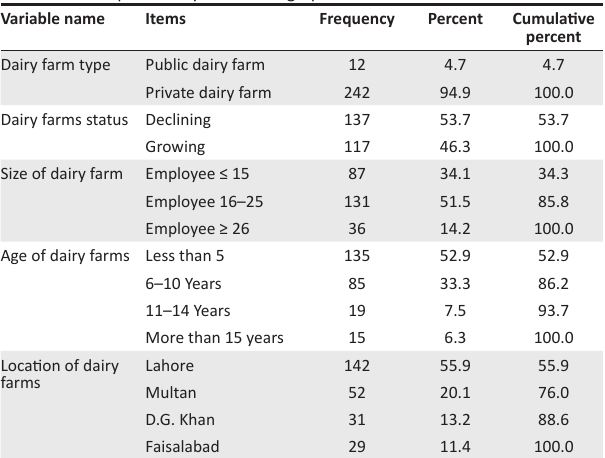
TABLE 1: Descriptive analysis of